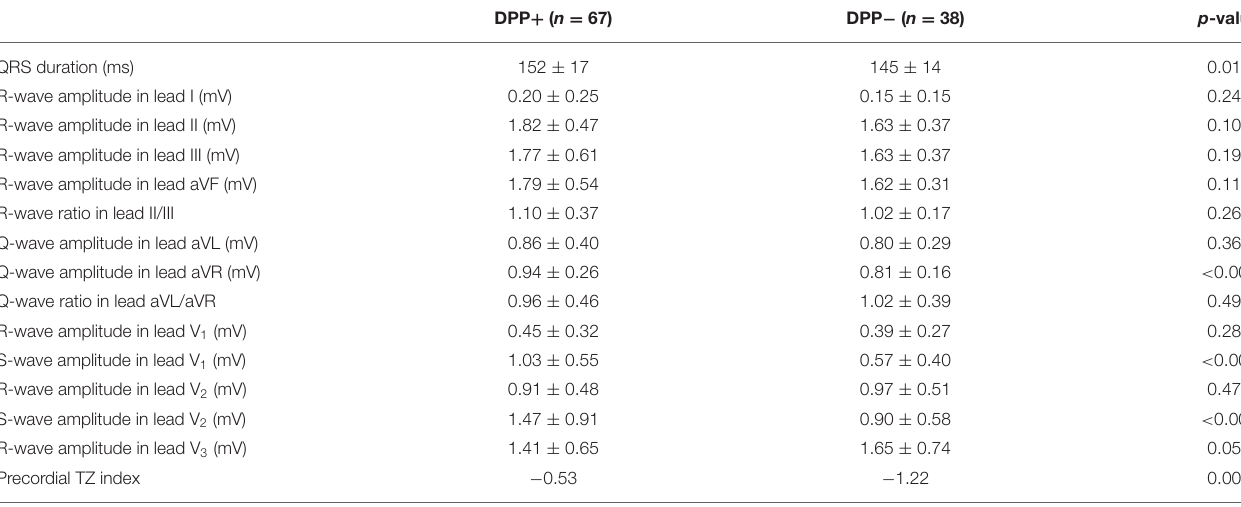
TABLE 2 | ECG parameters during the VAs between patients with and without DPP.